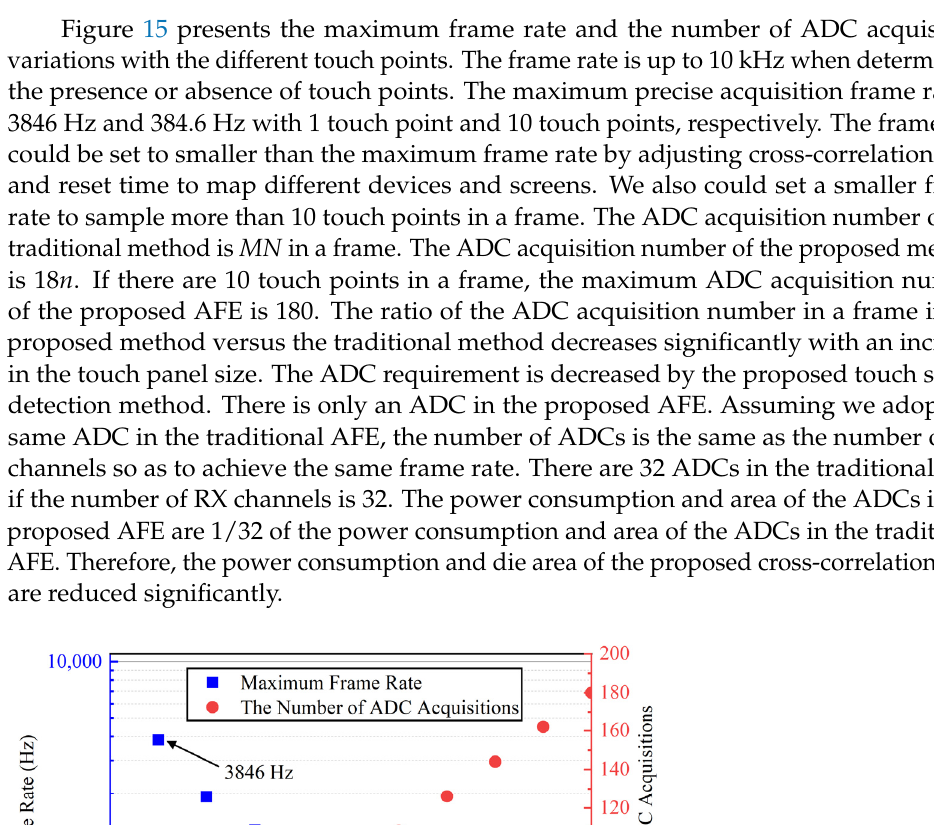
Figure 14. The computing complexity of the traditional method and the proposed method, with the different number of RX channels and the different number of touch points in a frame.